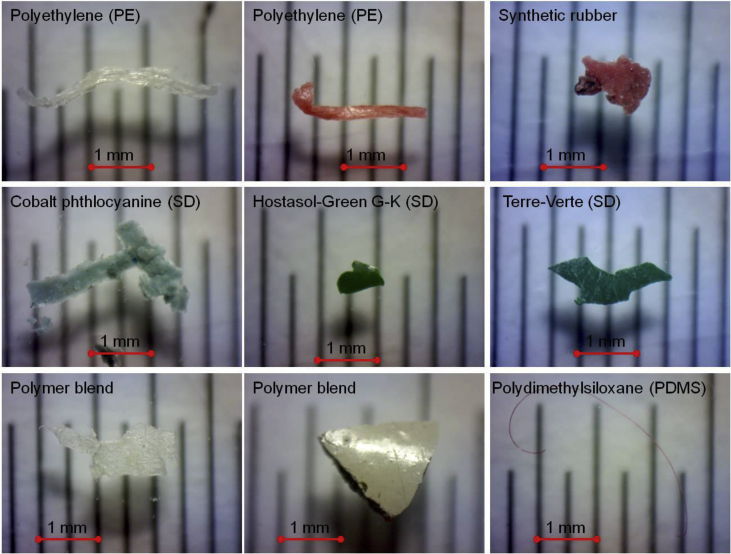
Polymer samples.